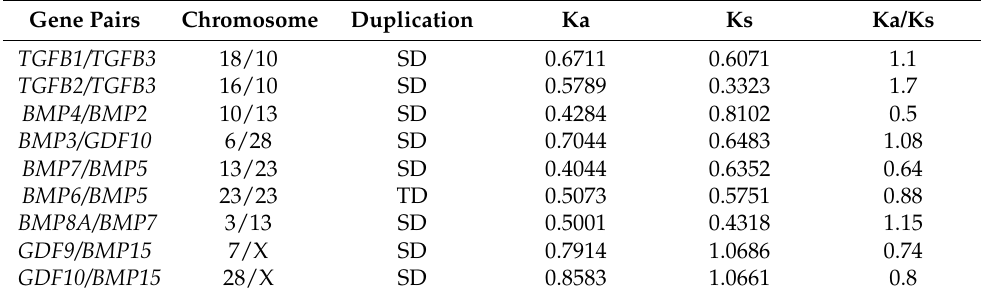
Figure 3. Buffalo and cattle TGF- β genes collinearity analysis. The chromosomes of the cattle are presented in green, and buffalo in yellow color. Table 4. Analysis of the Ka/Ks ratio for each duplicated gene pair of the buffalo TGF- β gene family. Gene